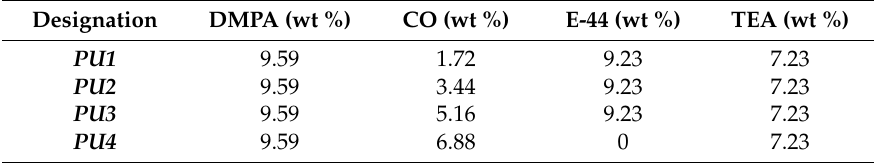
Table 1. Designations of wrinkling patterned waterborne cross-linked